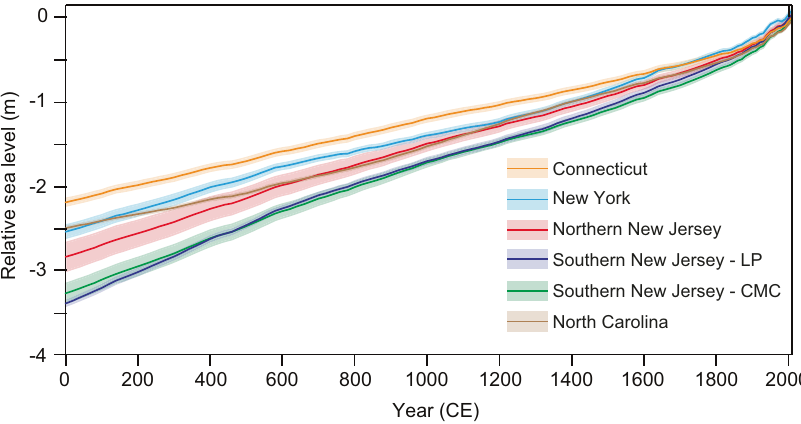
Fig. 2 Common Era relative sea-level model predictions for U.S. Atlantic coast sites. See Fig. 1a for site locations. Model predictions are the mean with 1 σ uncertainty. LP Leeds Point. CMC Cape May through the Common Era (Fig. 4). By 1950, global sea-level change was responsible for 36 – 50% of RSL change at each site. Sea-level budgets: regional linear component . The dominant processes driving RSL change at U.S. Atlantic coast sites are regional-scale and temporally linear, contributing 2.1 – 3.2 m of rise over the Common Era (Fig. 4). In northern New Jersey, the linear rate contribution is 1.3 ± 0.08 mm yr − 1 (Table 1). The lin- ear component exhibits a spatially variable signal, with the greatest